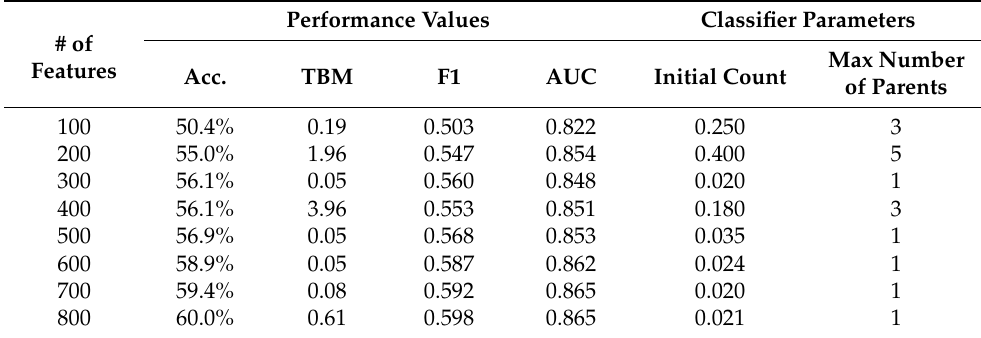
Table 8. The best performance of BNC over different feature sets.